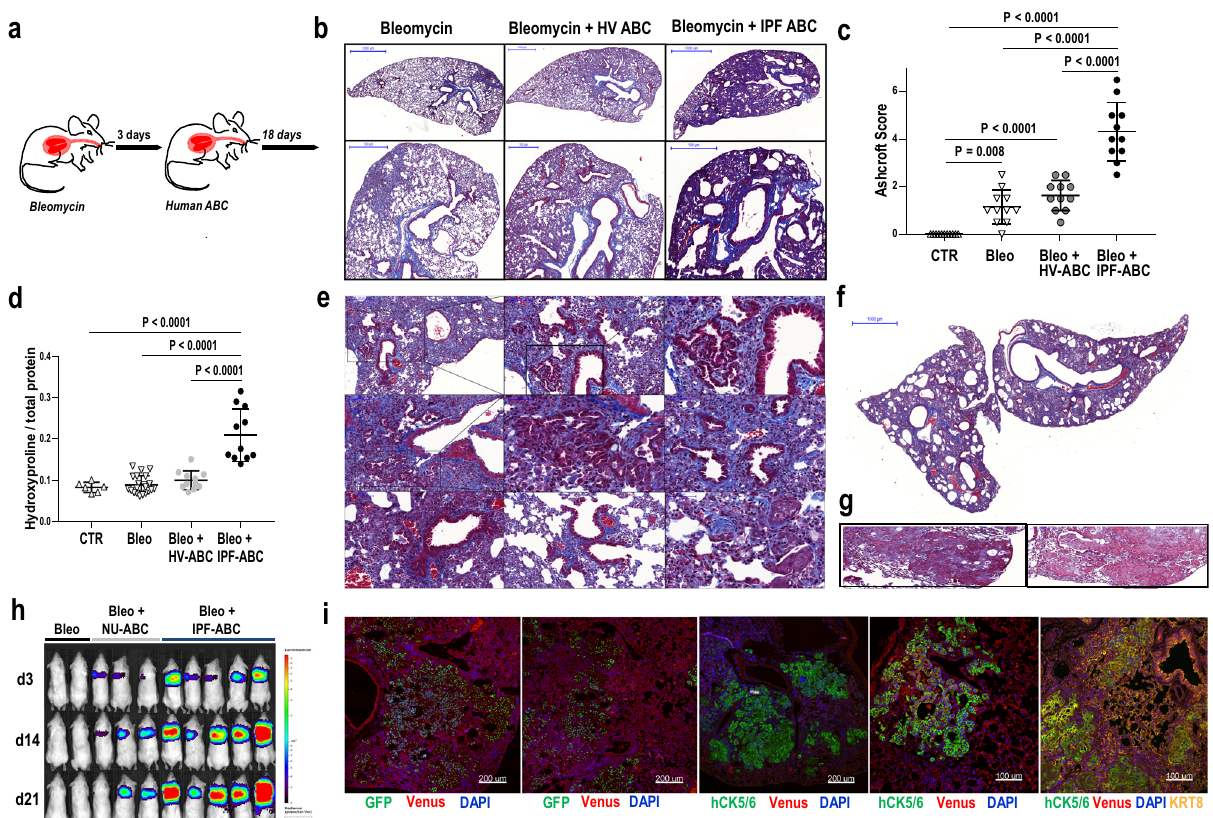
Fig. 3 | Establishment of a humanized mouse model for IPF based on human ABCs. a Bleomycin (Bleo) was intratracheally administered to Rag2 − / − mice (BL6 background). Three days later human airway basal cells (ABC) derived from either patientswith IPFor HVwereintratracheallyadministered.Lungs wereharvestedat day 21 following Bleo application. b Representative trichrome stainings of mice challenged with Bleo alone, Bleo and HV-ABCs or Bleo and IPF-ABCs (each arm n =11, 2 replicates with similar results). Fibrosis and cystic lesions are increased in mice challenged with Bleo+IPF-ABCs. c , d Ashcroftscore(mean±SD;2 replicates) and hydroxyproline levels (mean±SD; 2 replicates) were signi fi cantly increased in mice challenged with Bleo+IPF-ABCs ( n =11) compared to mice challenged with Bleo and HV-ABCs ( n =11) or Bleo alone ( n =21). e , f Trichrome staining of mice injectedwithBleo+IPF-ABCs, shownare representativelesionsof11differentmice ( n =11, 2 replicates with similar results). Bronchiolization of the alveolar compart- mentanddenovogenerationofairwaystructuresishighlyincreasedinthesemice compared to mice challenged with Bleo alone or Bleo+HV-ABCs. These bronch- iolar lesions look often bizarre and undirected. Others appear to resemble hon- eycomb cysts. New collagen synthesis (shown in blue) is seen